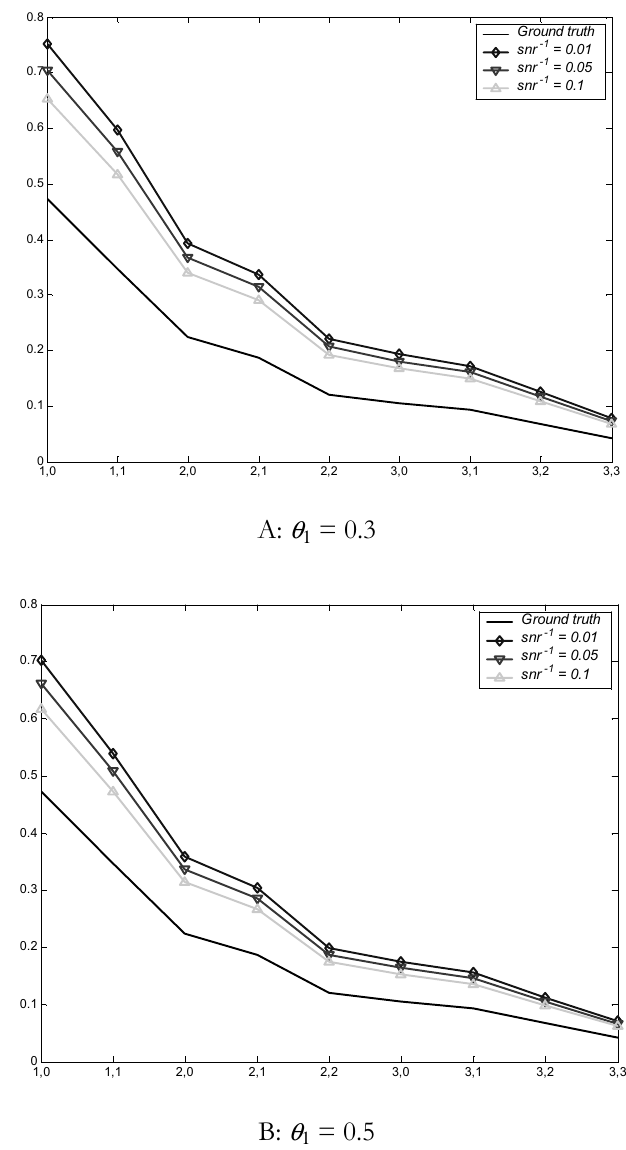
Figure 2 – Spatial correlation distortions in the remotely acquired images for various values of lo- and snr ), under model (11), for the weak dependency case ation and attribute error parameters ( θ 1 ( β = 0.75 in equation (12)). Error-corrupted correlations are reported in the graph for spatial lags ( k , h ), k , h = 0, ..., 3, when snr -1 =0.01, 0.05, 0.1, θ = 0.3 (Plot A), and θ = 0.5 (Plot B). 1 1 as discussed by Benedetti and Espa (1993), is simulated by filtering a